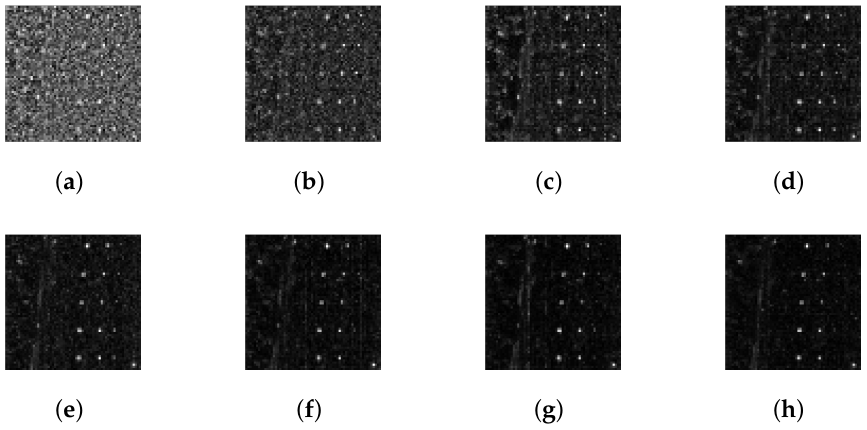
Figure 9. Detection abundance fractional maps of HYDICE by R-LS-RXD with different sliding window size: ( a ) ω =5; ( b ) ω =7; ( c ) ω =9; ( d ) ω =11; ( e ) ω =13; ( f ) ω =15; ( g ) ω =17; ( h )